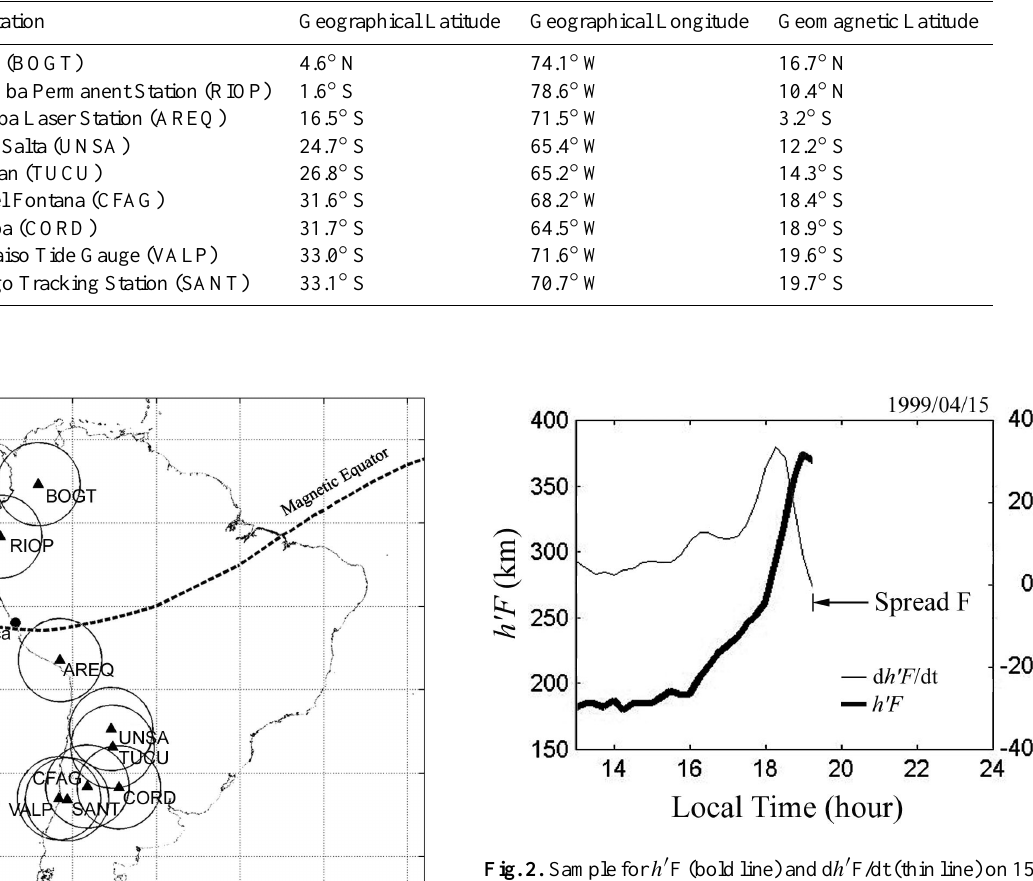
Fig. 2. Sample for h 0 F (bold line) and d h 0 F/dt (thin line) on 15 April 1999. The maximum value of d h 0 F/dt is ∼